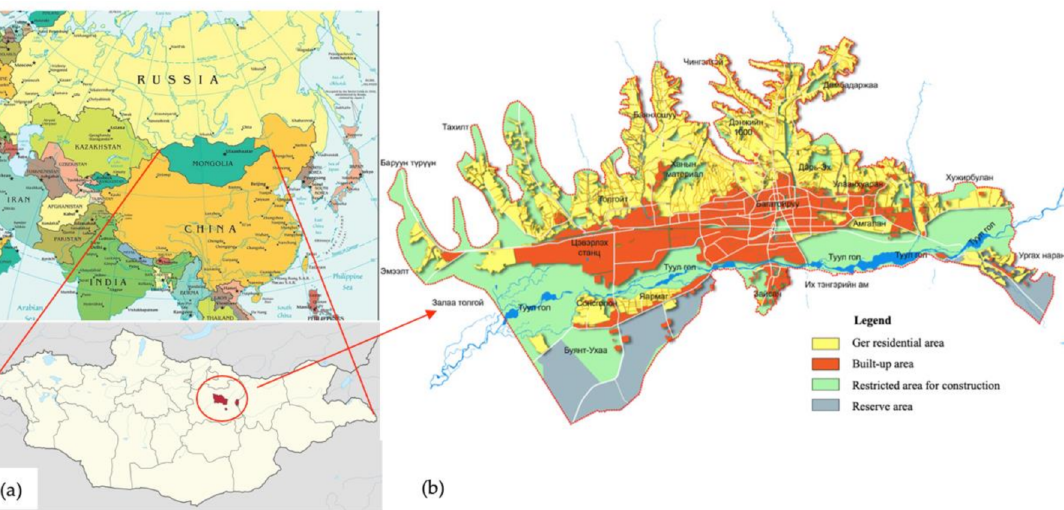
Figure 1. Residential zoning map of Ulaanbaatar city (ger and built-up area). ( a ) Source: https://mn.wikipedia.org/wiaki/ Улаанбаатар (accessed on 3 August 2021). ( b ) Source: Ulaanbaatar Planning and Designing Institute,